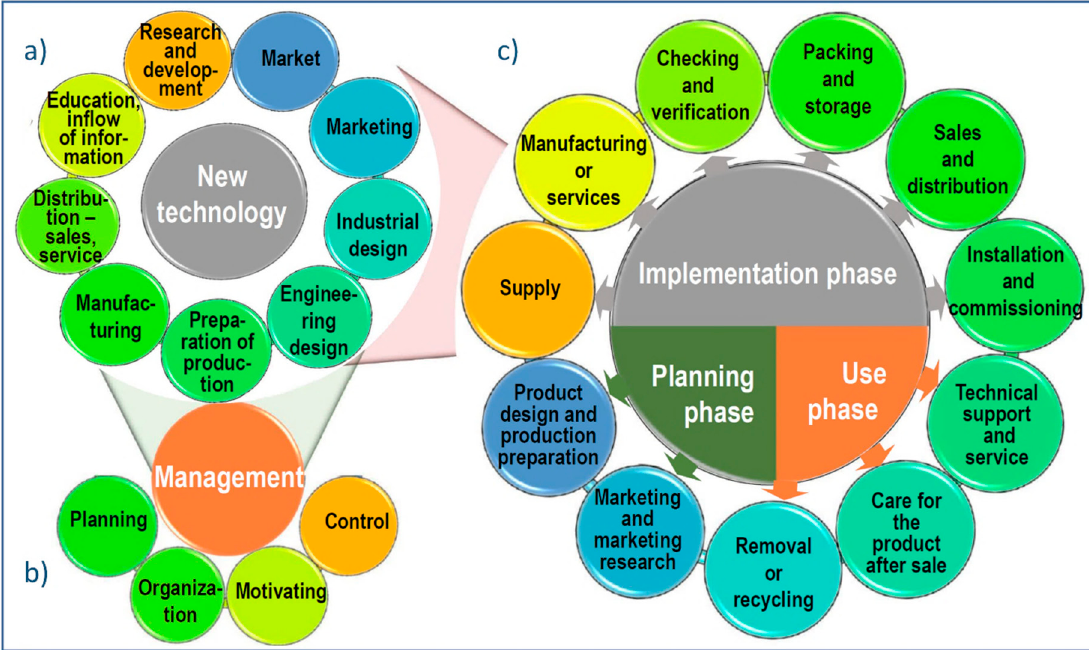
Figure 19. Diagram of the ( a ) interdependence of factors related to the introduction of a new product and a new technology to the market, ( b ) with production management, ( c ) and the product life cycle included in the quality loop.